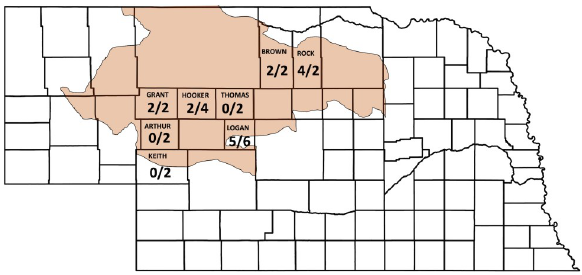
Fig 1. Map of the Sandhills. Shaded in red are the Sandhills in Nebraska, where grass and root zone soil were collected in 2016 and 2017 for the present study. Rhizoctonia spp. were isolated from samples collected from 11 sites in